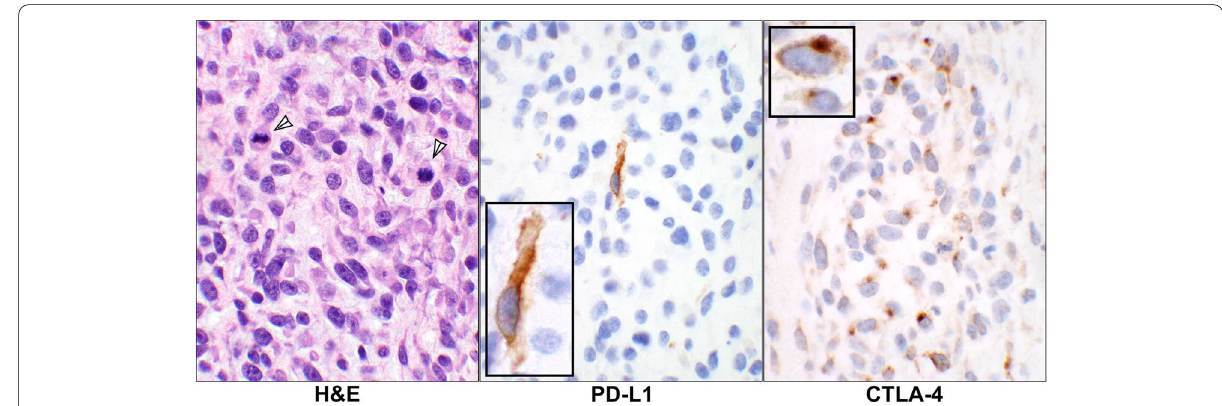
Fig. 6 Staining reactions in endometrial stromal sarcoma. H&E stain of a case of a uterine endometrial stromal sarcoma showing unform malignant stromal cells containing mitotic figures (arrowheads). The corresponding PD-L1 stain shows a single tumor cell with the cell membrane reactivity and CTLA-4 IHC displaying positive granular cytoplasmic staining of the malignant cells which are very similar to that in the control tissue as seen in Fig. 1 (case# 63, Additional Table 1). (20 objective, insets: 60 objective). Abbreviations: H&E, hematoxylin & eosin; PD-L1, programmed × × death-ligand 1; CTLA-4, cytotoxic T lymphocyte antigen